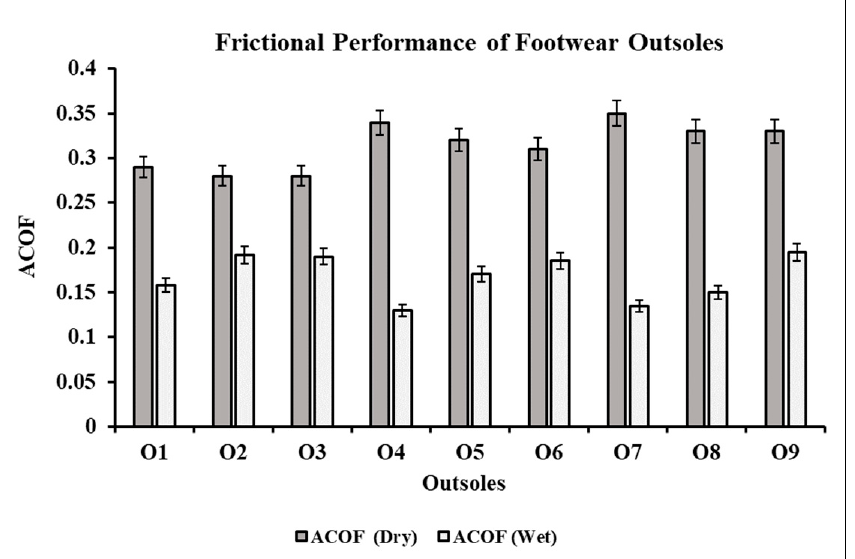
Figure 5. Frictional performance of the outsoles tested using the mechanical slip tester across dry and wet slipping conditions.